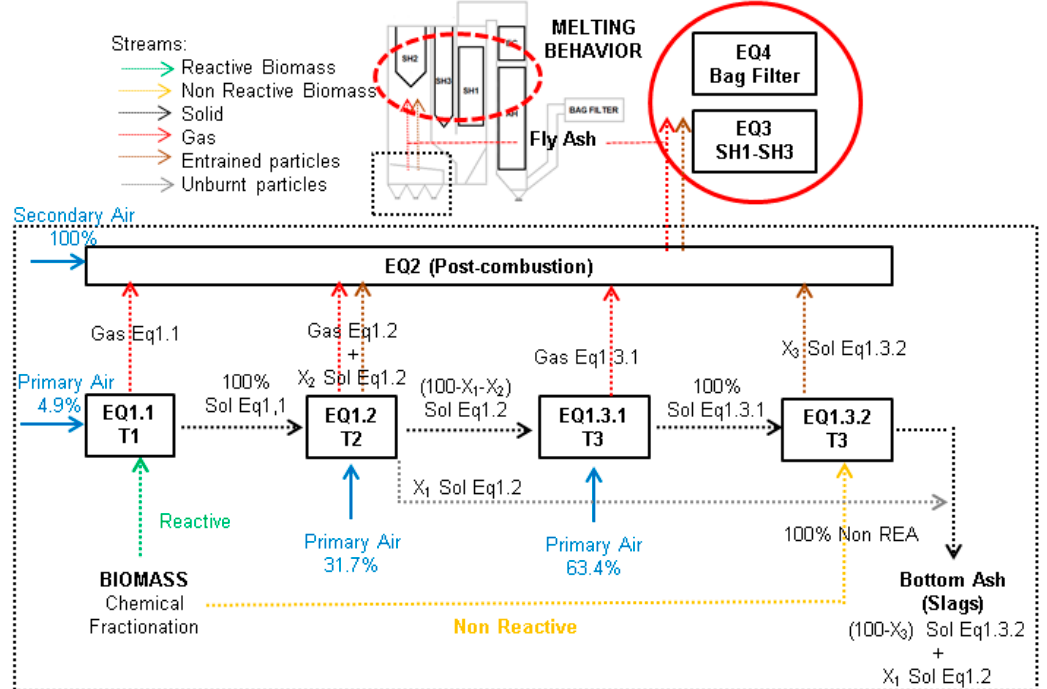
Figure 2. Scheme of the model representing the power plant by means of the main stages and streams involved.